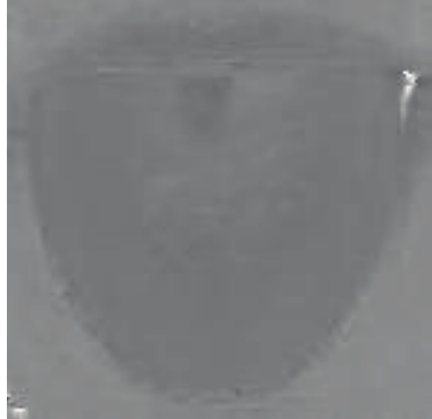
Figure 7: Hue image after transformation.